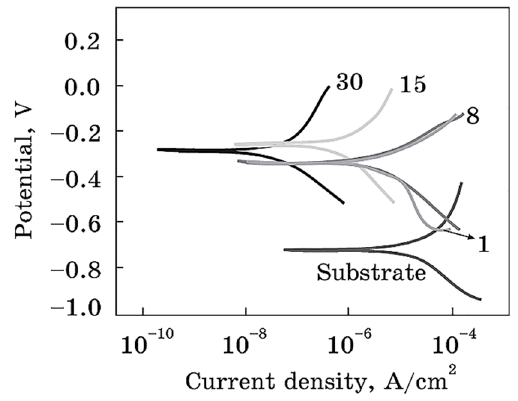
Figure 18. Cathodic and anodic Tafel polarization curves for CrN/ZrN multilayer coatings with different number of bilayers (1, 8, 15, 30) [147].